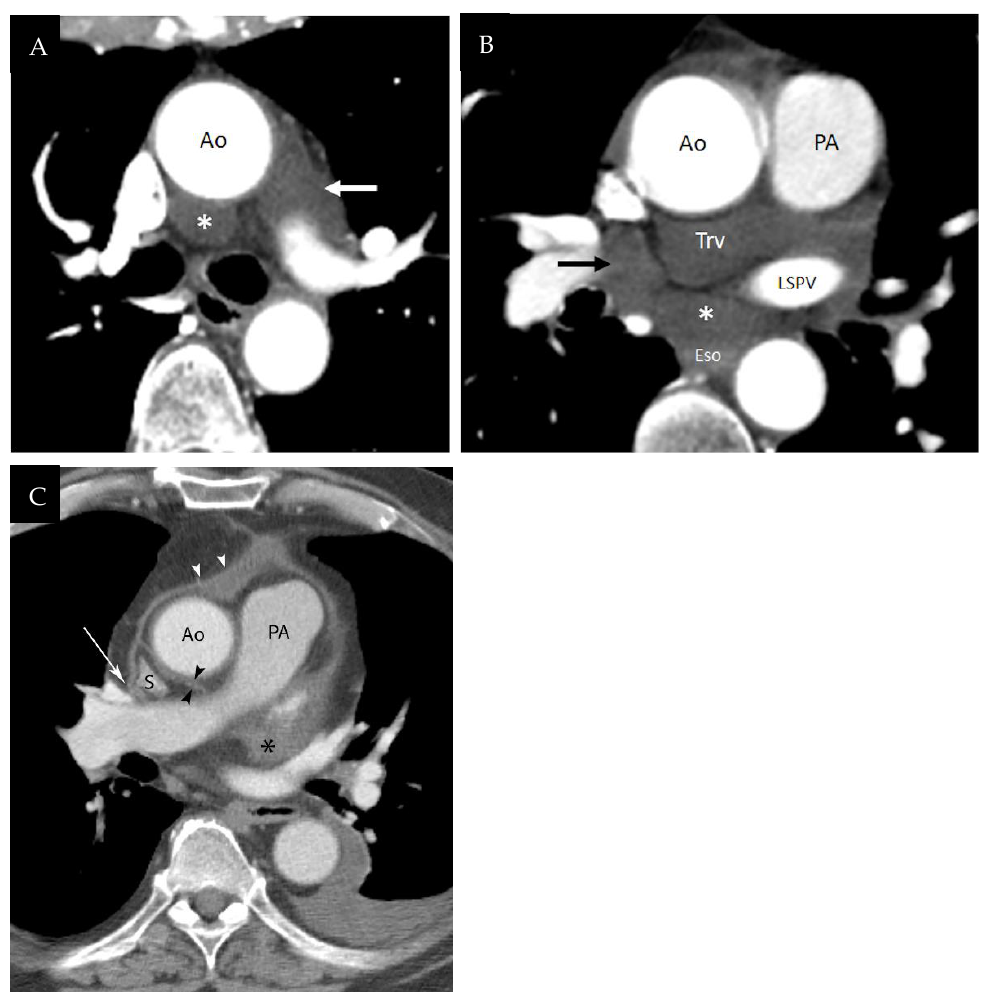
Figure 1. Normal pericardial recess anatomy. ( A ) Contrast-enhanced axial CT at a level just superior to the main pulmonary artery shows fluid in the superior pericardial recess (*) and in the AP window recess (arrow). These recesses are part of the transverse sinus. ( B ). Contrast-enhanced axial CT at a level just inferior to the right pulmonary artery shows fluid in the transverse sinus (Trv), oblique sinus (*), and postcaval recess (arrow). Ao = ascending aorta, Eso = esophagus, LSPV = left superior pulmonary vein, PA = pulmonary artery. ( C ). Contrast-enhanced axial CT at the level of the right pulmonary artery shows a small amount of fluid in the postcaval recess (arrow), a diverticulum of the pericardial cavity proper lateral and posterior to the superior vena cava (S). Pericardial fluid is seen posterior (black arrowheads) to the ascending aorta in the superior aortic recess, anterior (white arrowheads) to the aorta (A) and pulmonary artery (PA) as well as in left pulmonic recess (asterisk) of the transverse sinus. Reprinted from Shroff, G.S et al. Pitfalls in oncologic imaging of the pericardium on CT and PET/CT [4].